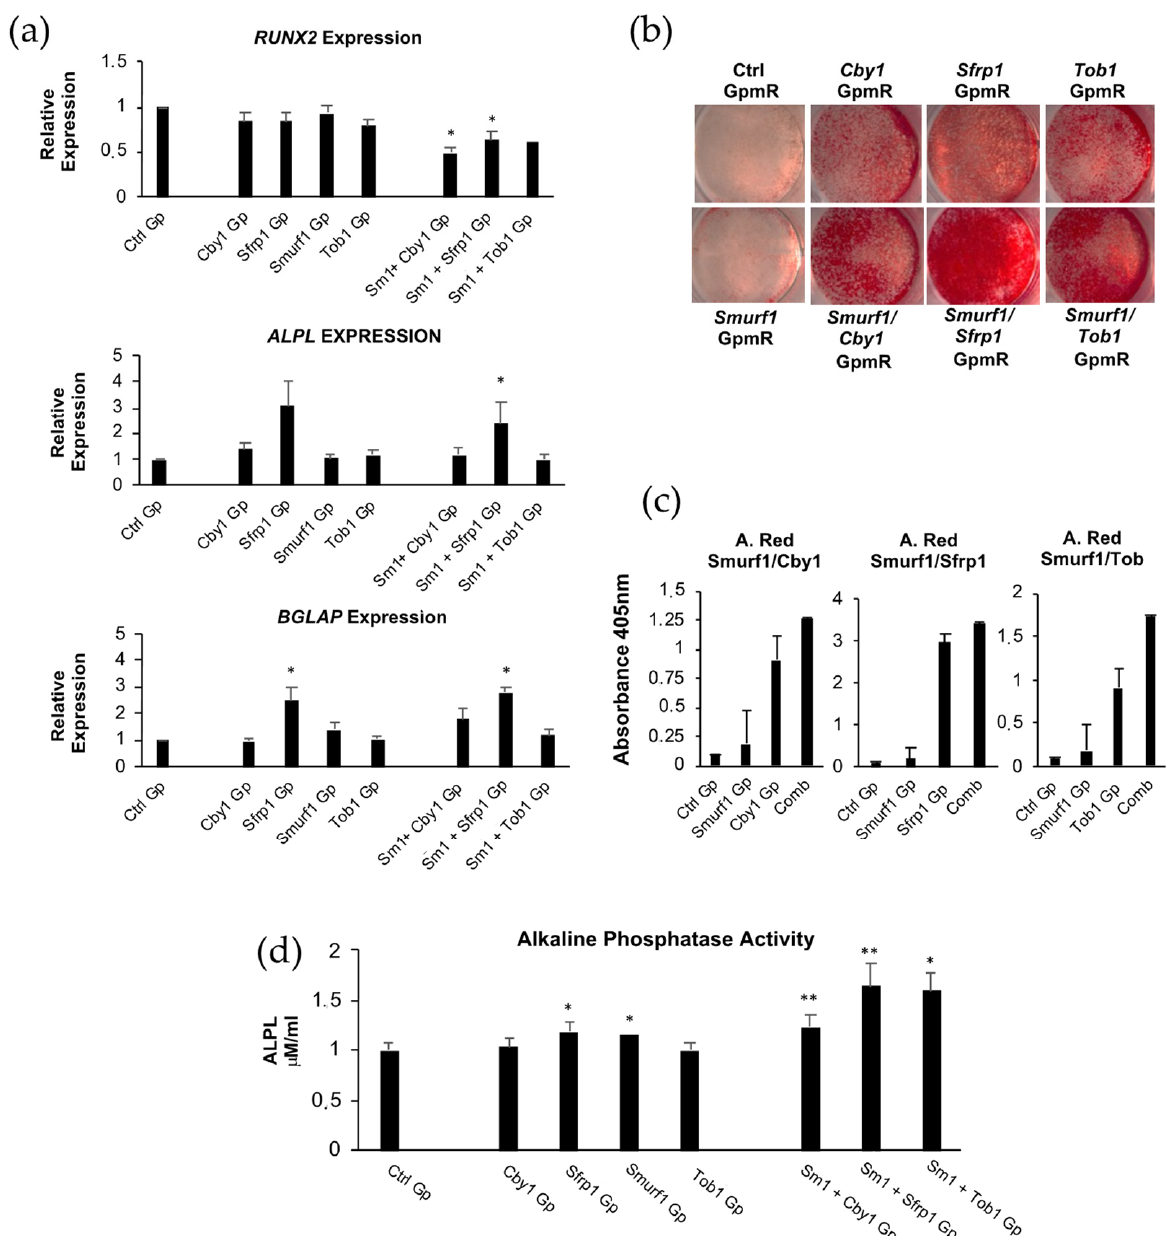
Figure 3. Osteogenic differentiation capacity of MSCs after the silencing of specific osteogenic inhibitors and their com- binations. Sm1 stands for Smurf1 in the GapmeR combinations. All analyses were performed on transfected cells that had undergone osteogenic differentiation for 11 days. All graphs represent average values of independently performed experiments. Error bars represent standard error of the mean values. For analysis performed on cells transfected with a single GapmeR ( n = 7) and for those performed with cells transfected with GapmeR combinations ( n = 5). ( a ) Expression of the osteoblastic differentiation driver Runx2 and osteogenic markers Alpl and Bglap . ( b ) Alizarin Red staining of cells transfected with GapmeRs or GapmeRs combinations growing in osteogenic media. The picture shows a representative experiment performed at day 11 of differentiation. ( c ) Graphs shows quantification of the Alizarin Red staining at 405 nm. ( d ) Graph shows alkaline phosphatase activity measured in the different conditions. (* p ≤ 0.05; ** p ≤ 0.005).